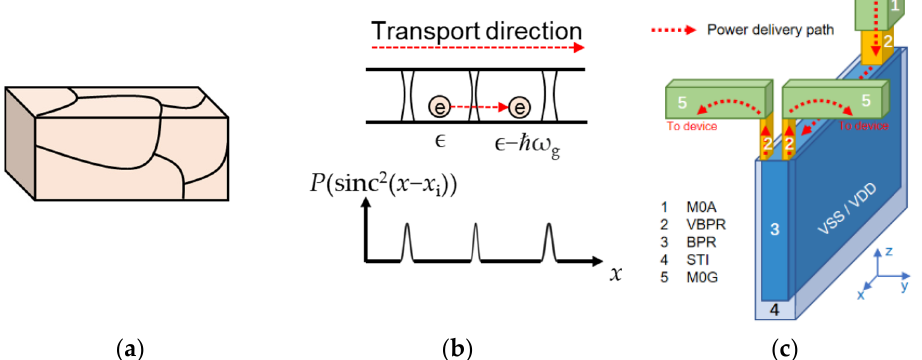
Figure 1. Schematic diagrams of simulated structures: ( a ) the simulated bulk-like structure and its grain boundaries, ( b ) the nanoscale interconnect grain boundaries and their Sinc function potential barriers, and ( c ) a schematic diagram of FS-BPR (front-side BPR) structure and power delivery path. In ( b ), an electron travels across a grain boundary and emits a phonon with energy ℏ ω g to lattice. In ( c ), electric power distributes along 1. M0A (metal contact to active), 2. VBPR (via to the BPR), 3. BPR, and 5. M0G (metal contact to gate). A BPR is surrounded by STI and buried partially in STI oxide and Si substrate.